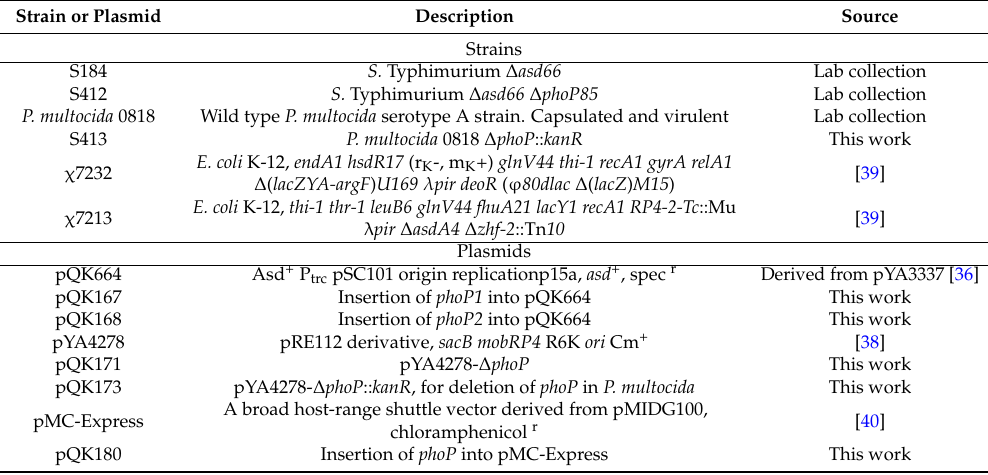
Table 4. Bacterial strains and plasmids used in the